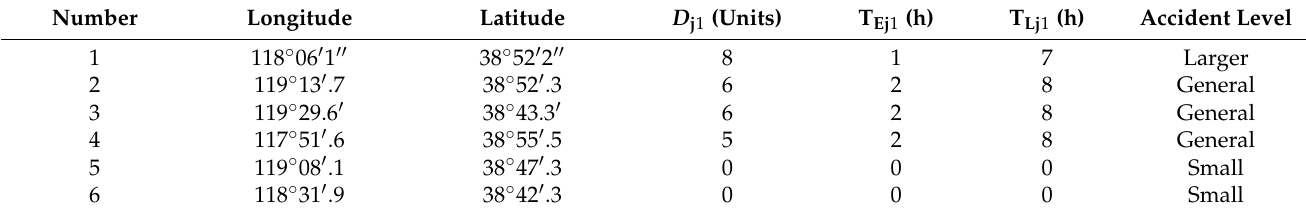
Table 4. Accident point